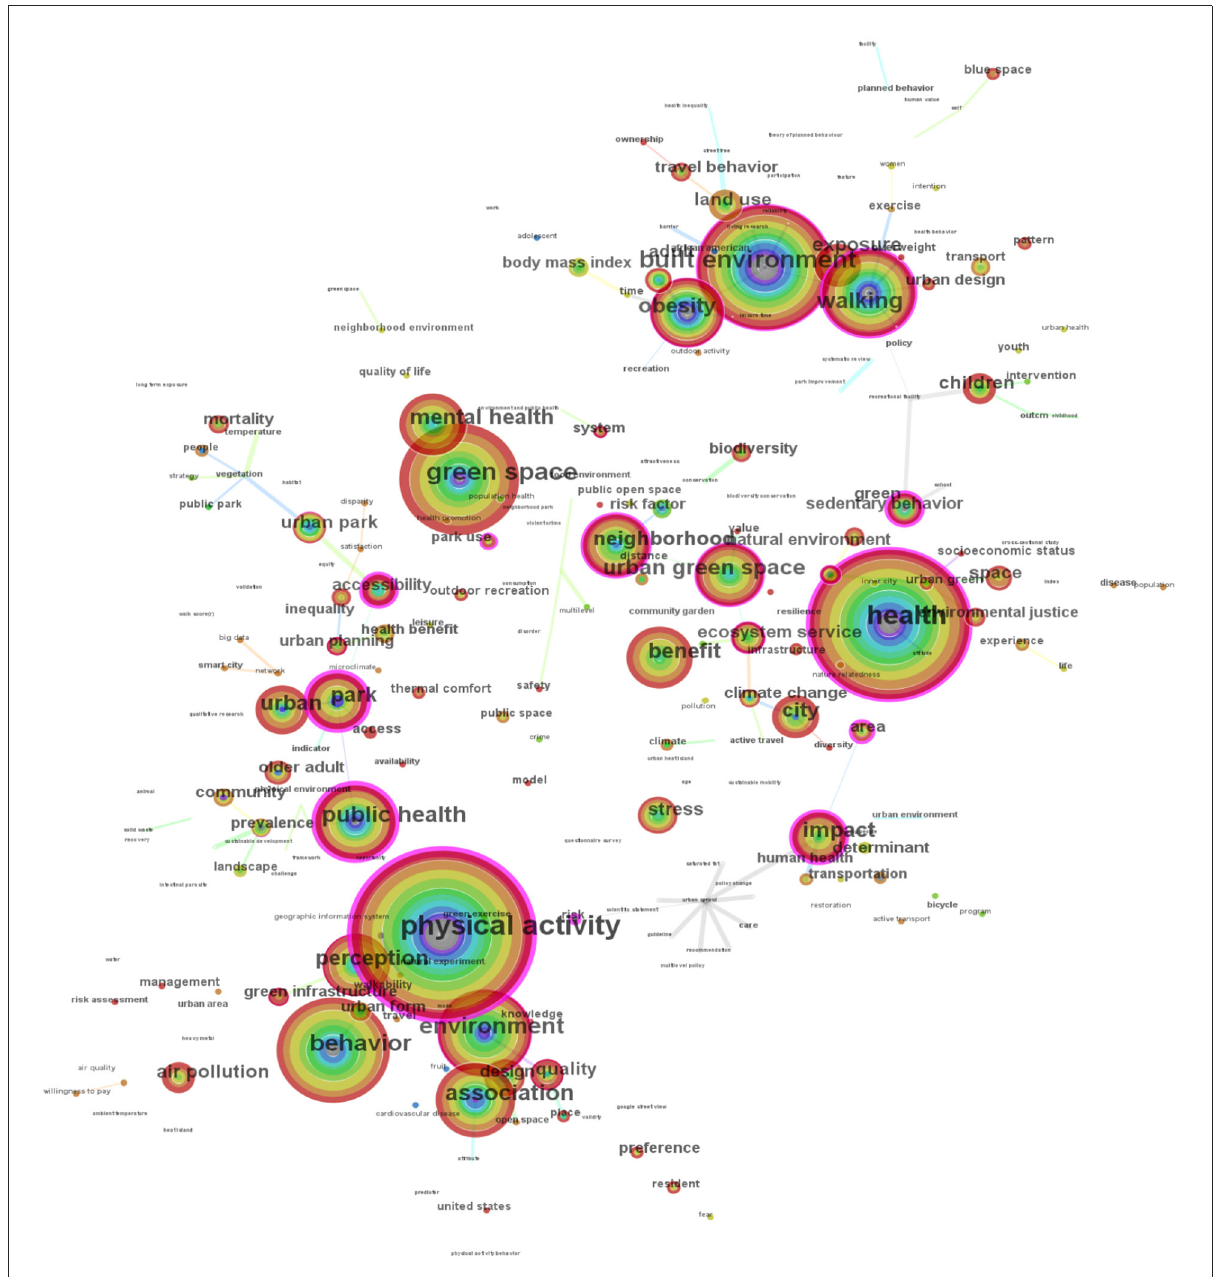
FIGURE6 Keywords co-occurrence